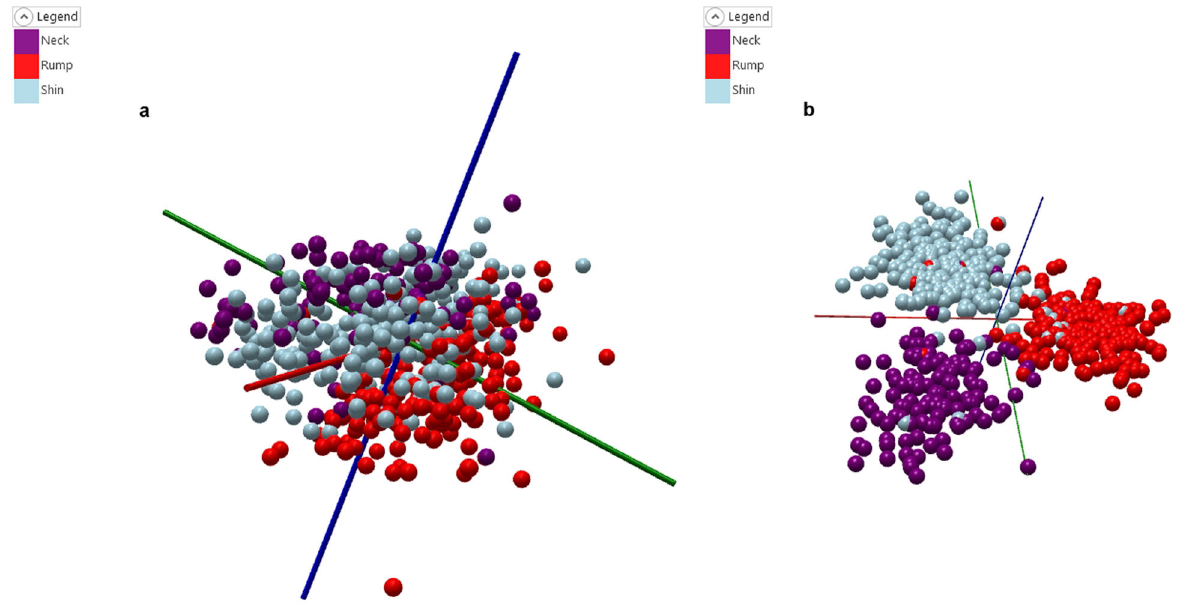
Fig. 1 Meat cut models. a PCA plot for the meat cut model, with clear groupings shown for neck, rump, and shin cuts. b PCA-LDA plot for the meat cut model, with clear separation shown between the three classes, but also showing some mislabelling present within the